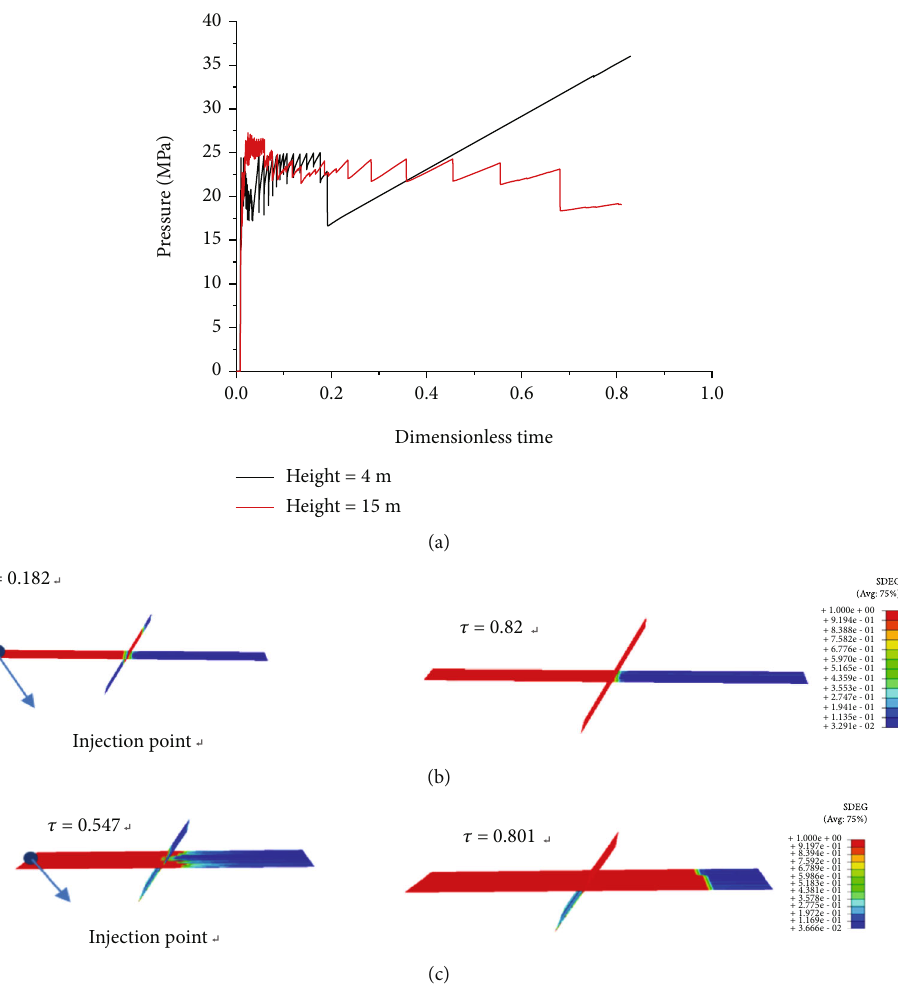
Figure 13: The numerical result comparison between 4 m and 15m formation thickness with a 60-degree approaching angle: (a) the injection pressure history at the injection location; (b) damage factor (SDEG) contours with a 4 m formation thickness (deformation scale factor is 100); and (c) SDEG contours with a 15 m formation